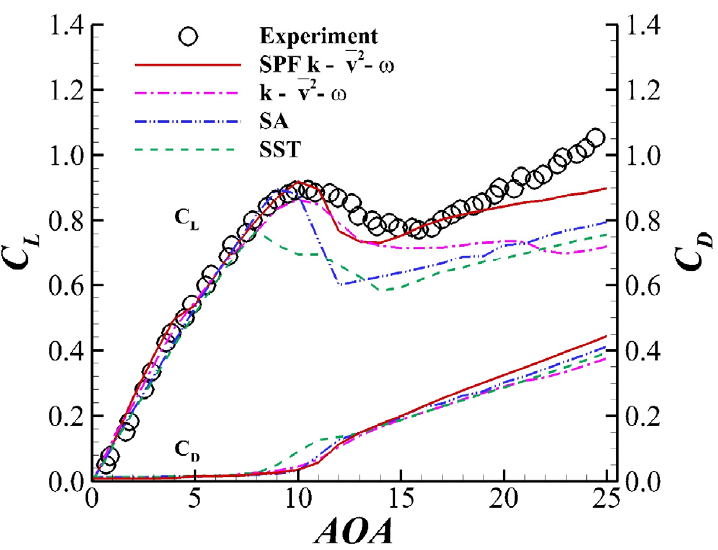
Figure 3. 𝐶 (cid:3013) − 𝐴𝑂𝐴 curve obtained by different turbulence models of the NACA64A010 airfoil Figure 3. C L − AOA curve obtained by different turbulence models of the NACA64A010 airfoil when Re = 3 × 10 5 and Ma = 0.12. The circles represent experimental data obtained by Broeren et al. [5]. when 𝑅𝑒 = 3 × 10 (cid:2873) and 𝑀𝑎 = 0.12 . The circles represent experimental data obtained by Broeren et al. [5].